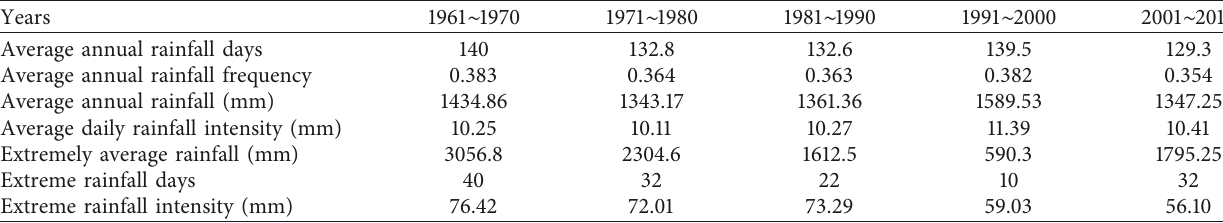
Table 1: Rainfall data in Changsha in recent 50 years.